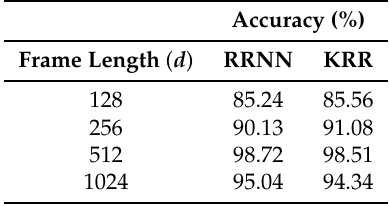
Table 2. Variation of testing accuracy with frame length.